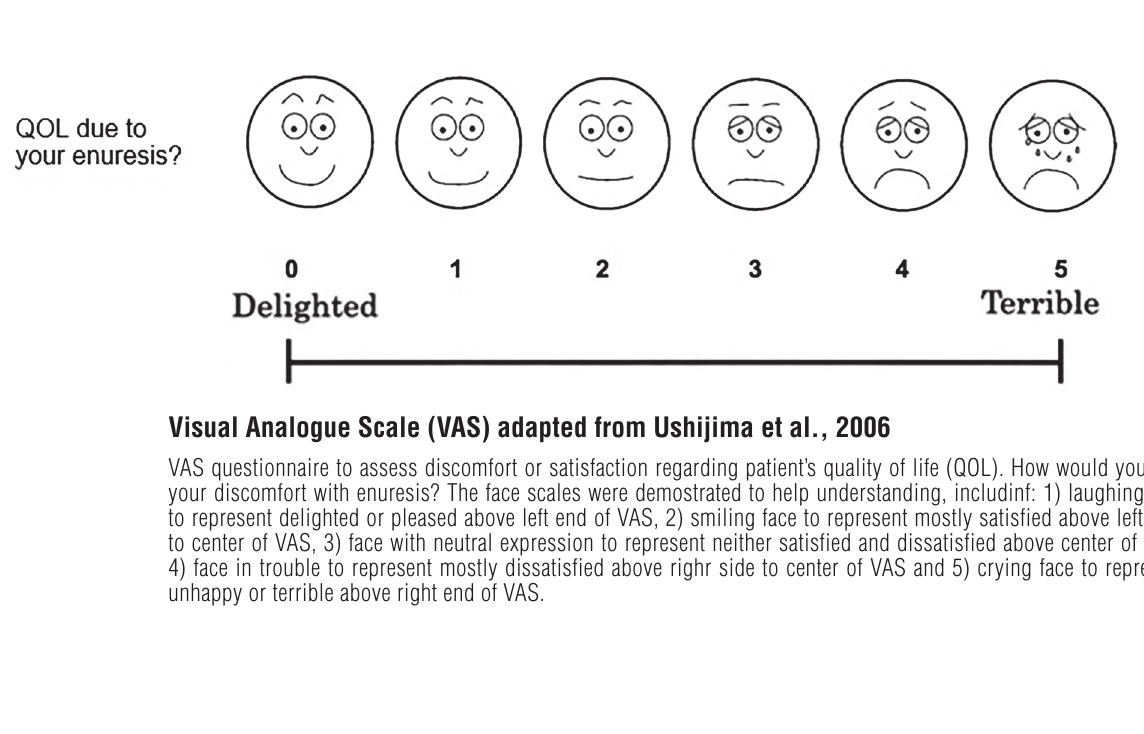
Figure 1 - Visual Analog